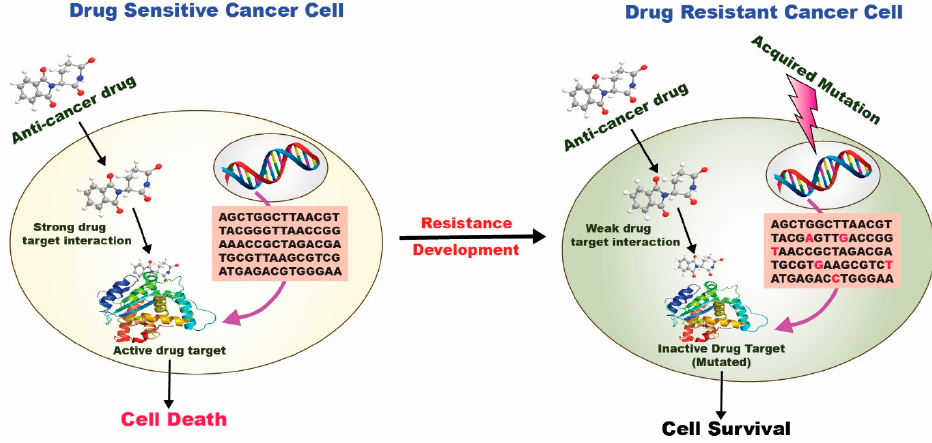
Figure 4. Drug resistance mechanism in a drug-sensitive and drug-resistant cancer cell [58].